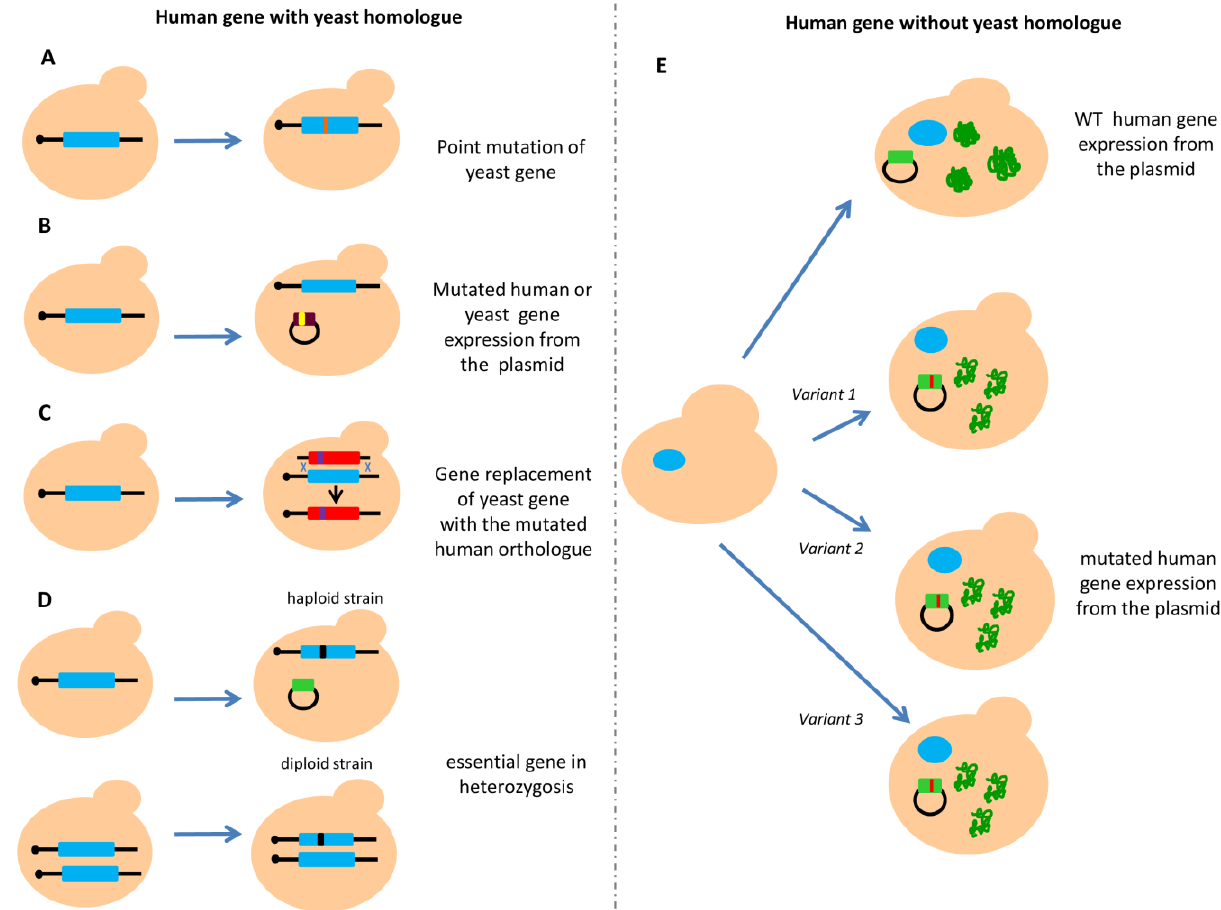
FIGURE 1: Constructions of humanized S. cerevisiae strains for functional analysis . Homology and complementation between yeast and human genes have to be considered for developing reliable functional assays. (A) When a yeast orthologue exists, yeast strains can be ma- nipulated by directly inserting the mutation in the nucleotide corresponding to the human gene. (B) Mutants of human or yeast orthologous genes can be expressed from a plasmid. (C) Mutants of human or yeast orthologous genes can be replaced with the human counterpart. (D) In the case of an essential gene, functional analysis has to be evaluated in heterozygosis expressing the wild type form of the gene from a plasmid and mutating the endogenous one, or mutating one of the two alleles in a diploid strain. (E) When no homology between the human and yeast gene has been identified, the human gene is expressed from a OPEN ACCESS | www.microbialcell.com